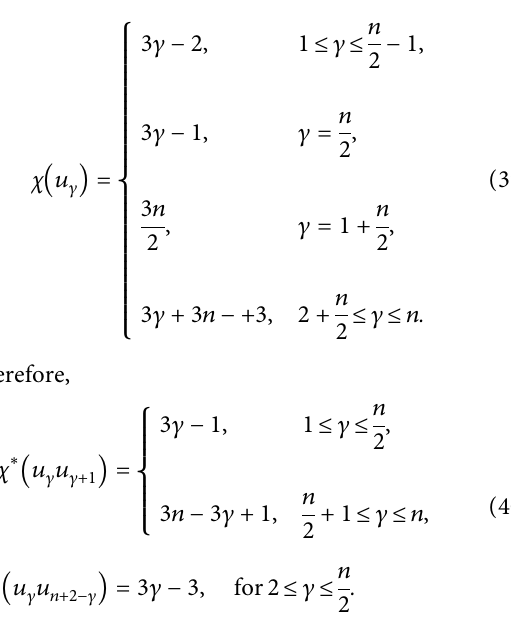
Figure 17: A classical mean labeling of latitude graph LL